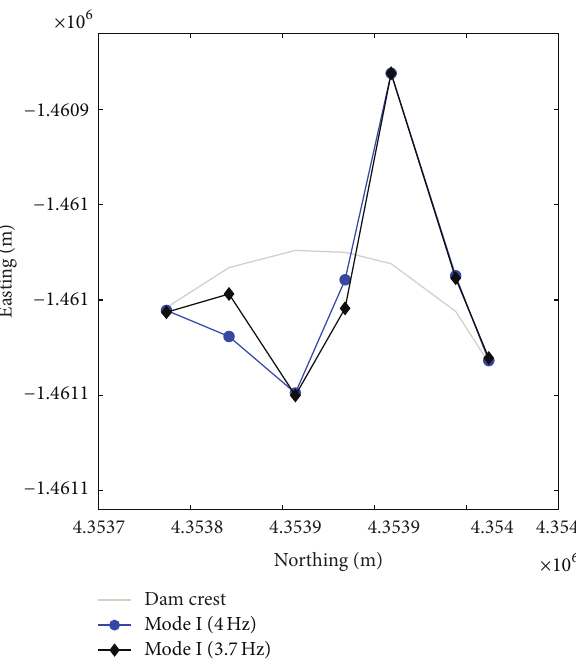
Figure 8: Normalised crest plot of the empirical first mode shape derived by the ambient vibration surveys with 27-metre water level (4 Hz) and 43-metre water level (3.7 Hz).